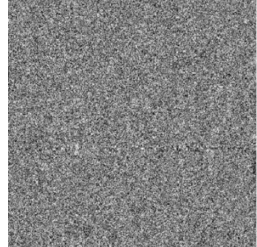
Figure 3. Final encrypted image.